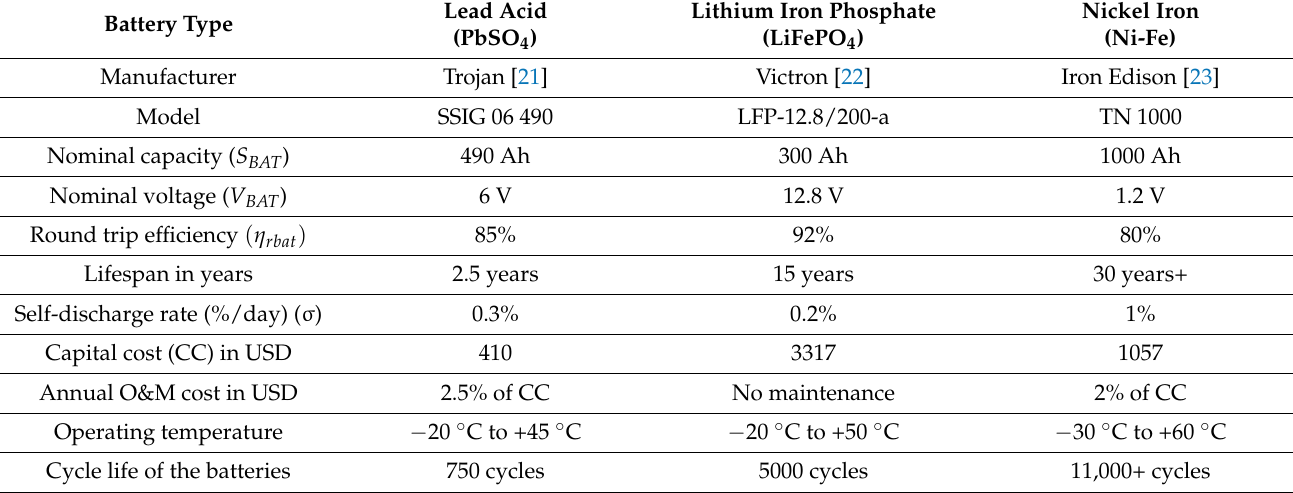
Table 3. The study’s technical and financial values of the